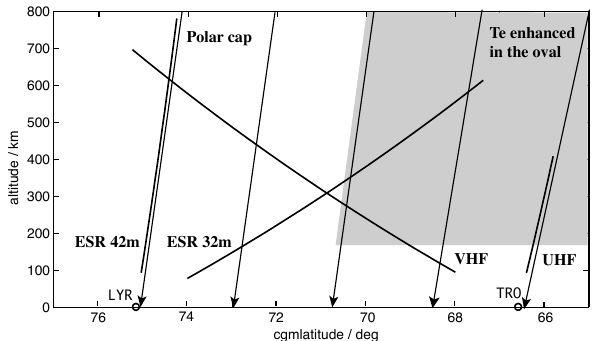
Fig. 1. Schematic figure of the method used in determining the PCB from the EISCAT measurements. Grey-shaded region represents the auroral oval, where T e is enhanced over a wide altitude range.